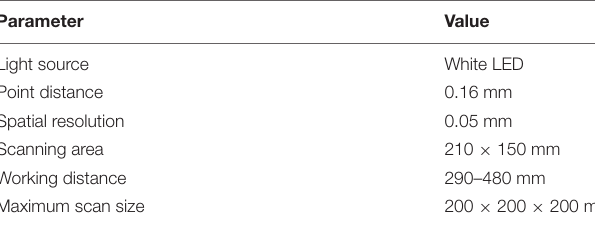
TABLE 1 | Detailed parameters of Reeyee Pro